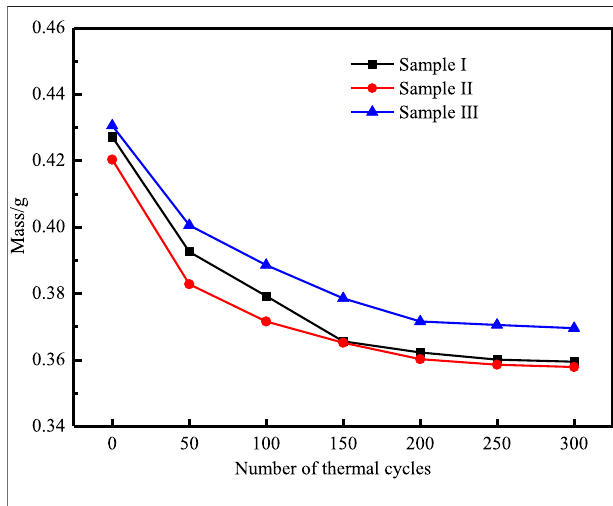
FIGURE 13 | Mass change of NaNO 3 /(SiO 2 + TiO 2 )/EG composite during 100 thermal cycles.